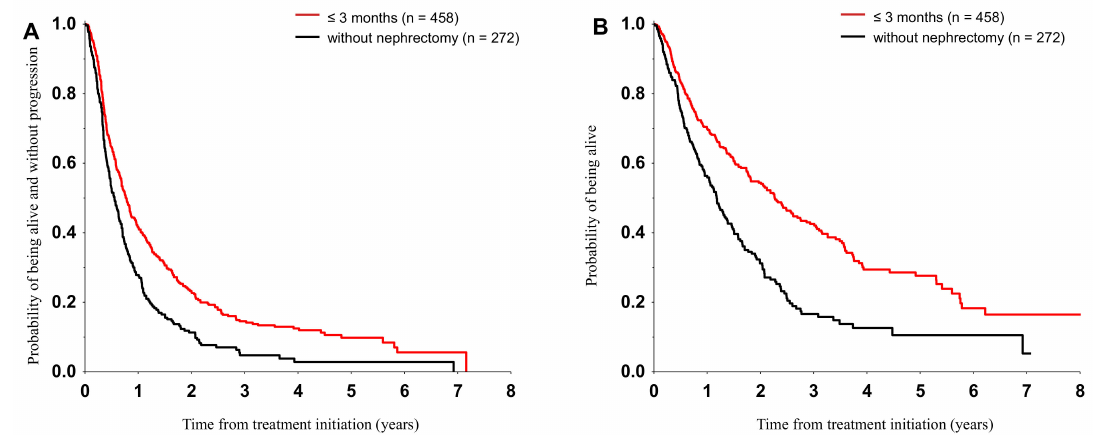
Figure 1. Progression-free ( A ) and overall survival ( B ) from first treatment strategy. All the di ff erences were statistically significant at p < 0.001.